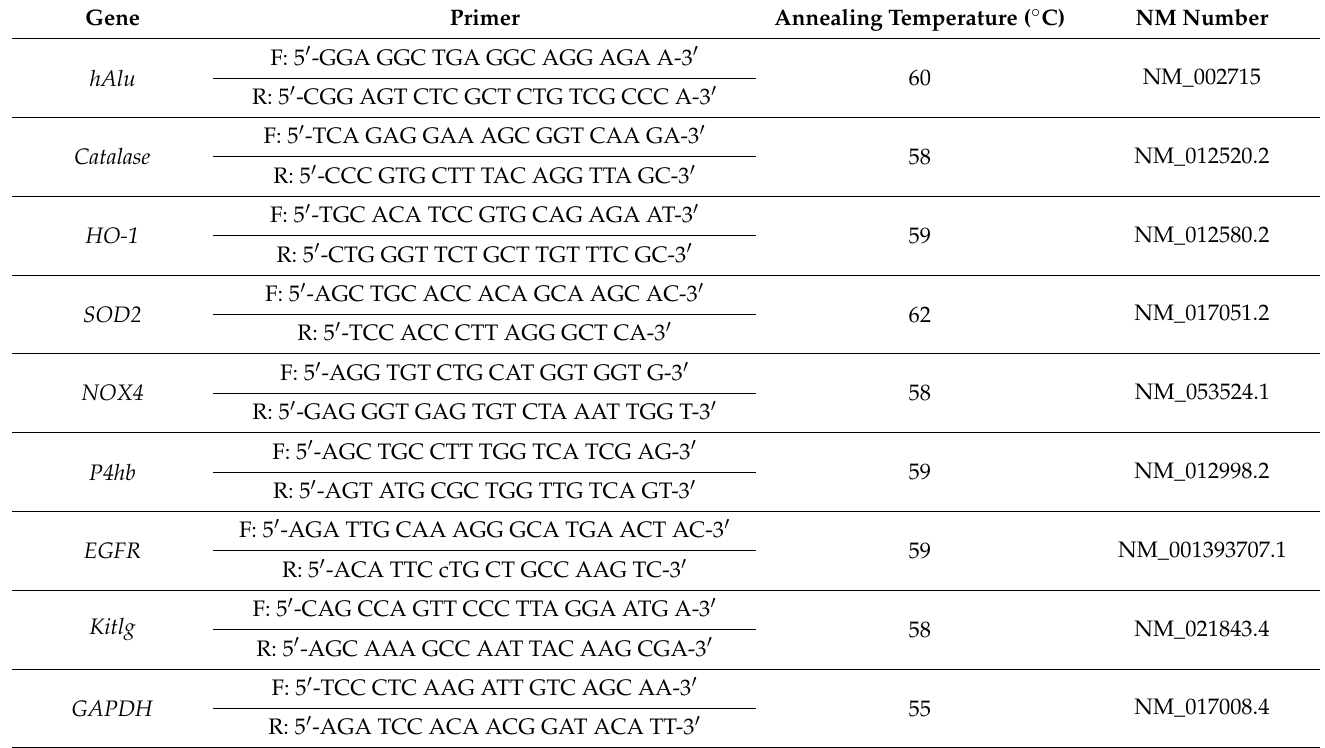
Table 2. Primer sequences using quantitative real time polymerase chain